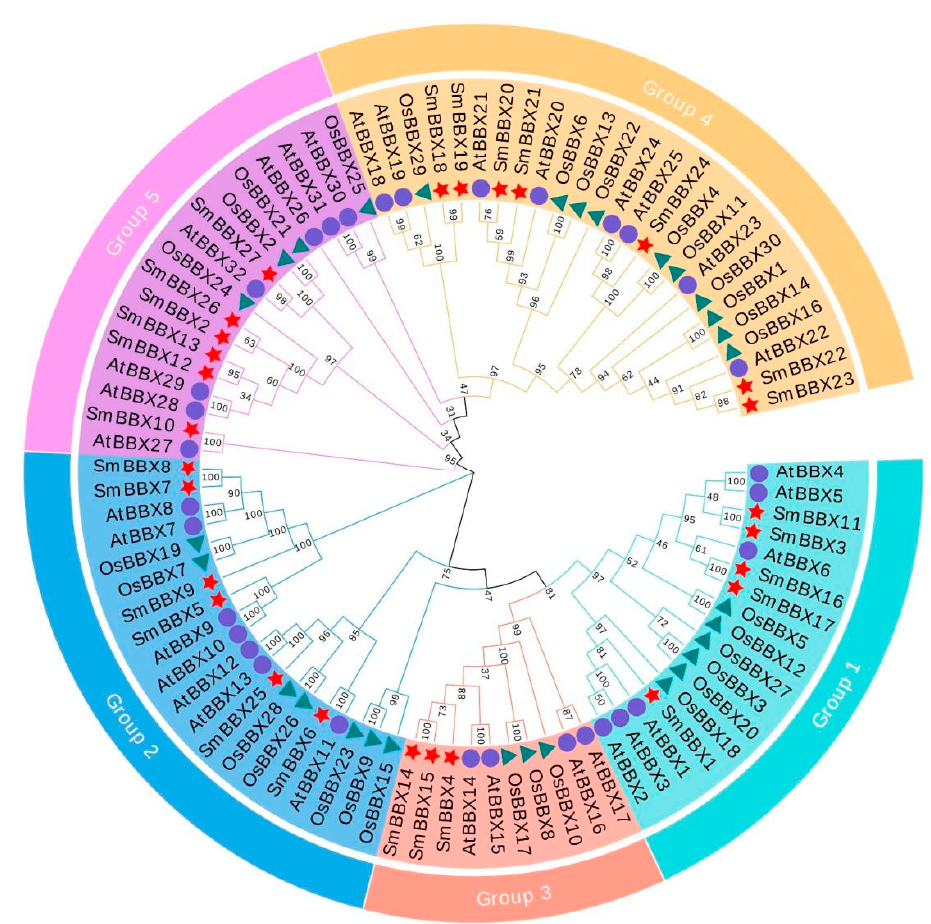
Figure 2. Molecular phylogenetic analysis of SmBBXs protein in Salvia miltiorrhiza . The phylogenetic tree using MEGA X with the neighbor-joining (NJ) method. The number at the branch represents the confidence value obtained by 1000 bootstrap tests. Eighty-nine BBX proteins were divided into five subclasses represented by different colored clusters. Red, orange, blue, purple, and green clusters represent subclasses I, II, III, IV, and V, respectively. Red stars, violet circles, and teal triangles represent Salvia miltiorrhiza , Arabidopsis thaliana, and Oryza sativa , respectively.